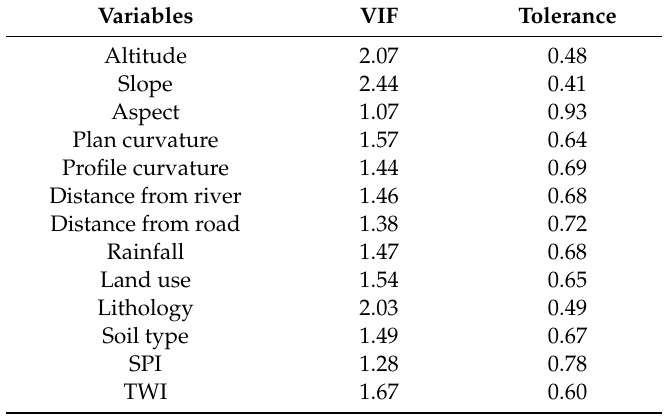
Table 1. Multi-collinearity analysis to determine the linearity of the independent variables.